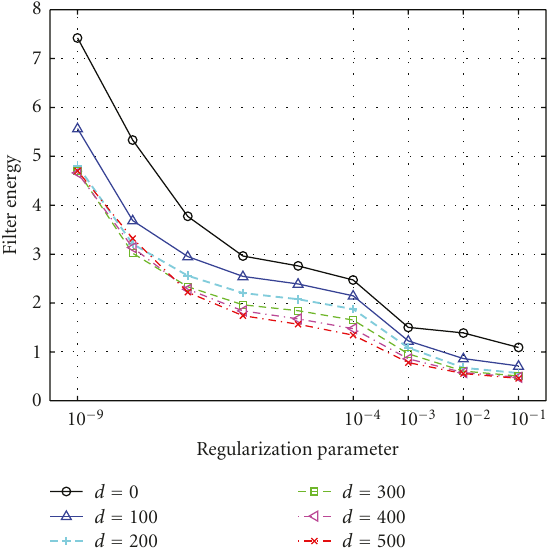
Figure 6: Performance as a function of regularization parameter and modeling delay with an SNR of 20dB (filter length is fixed at M = 1333).